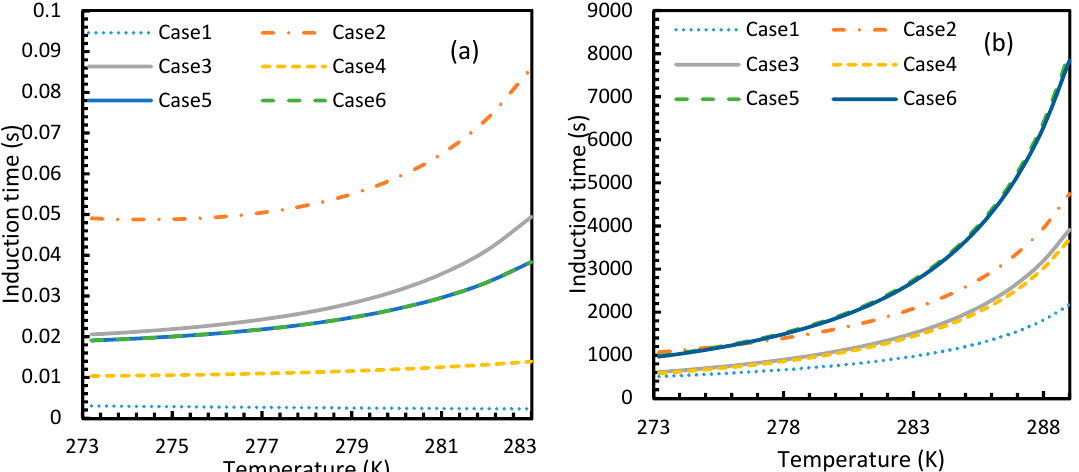
CO 2 profiles shown in Figure 3a.